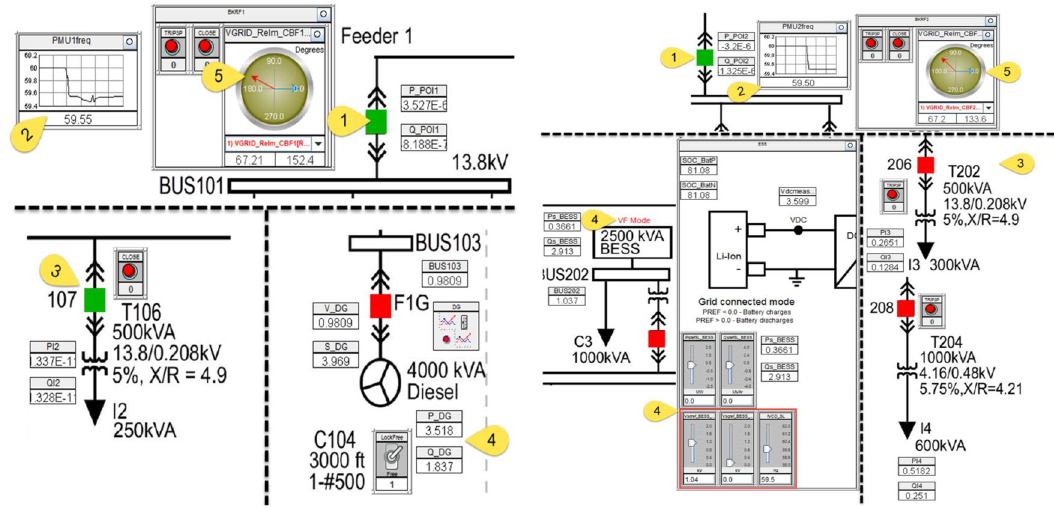
Figure 8. Islanding Area 1 or Area 3 vs. Area 2 6